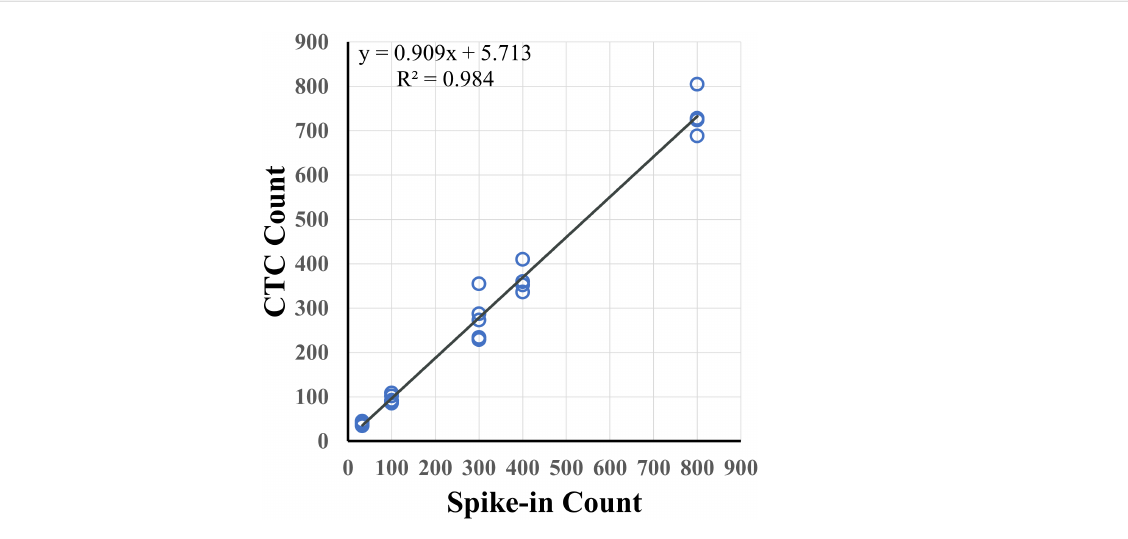
FIGURE 2 Spike-in recovery for different levels of tumor cells in 7.5 mL of healthy blood. Varying numbers of pancreatic (AsPC-1, Capan-2) and prostate (22Rv1) cancer cells were spiked into 7.5 mL of healthy blood samples with an overall recovery rate of 90.9% (R 2 =